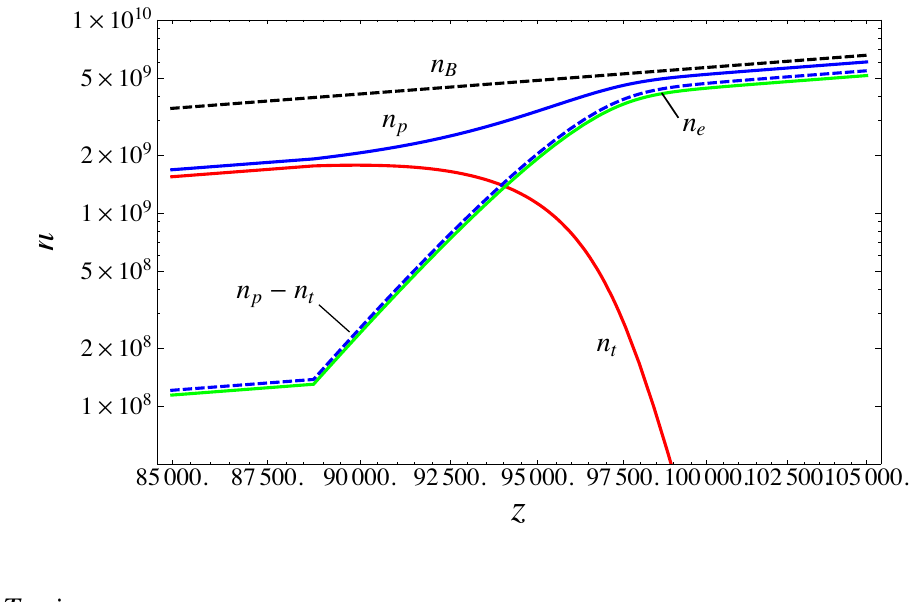
Figure 4. The same as Figure 3, but on a finer scale through the transition with the electron density in dotted green and the ordinary matter part of the proton density in dashed blue (see text). Note: the latter density has been reduced by 10% and the electron density by 15% for graphical